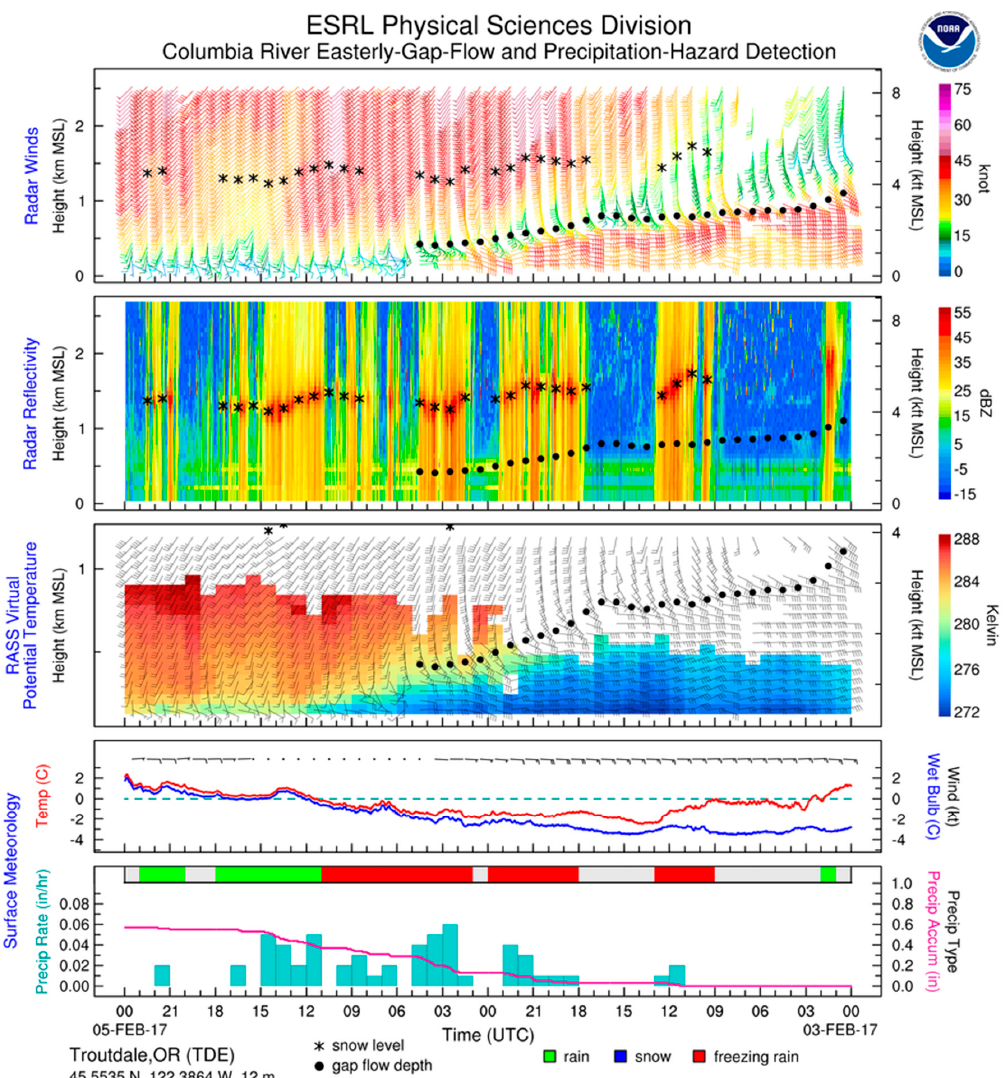
Figure 5. Gap flow events through the Columbia River Gorge, shown in the Winter Gap Flow tool. Top panel shows the time–height section of hourly radar wind profiles (flag: 50 kt, barb: 10 kt, half-barb: 5 kt) color coded by wind speed (kt). Hourly measurements of the snow level and the top of the gap flow are marked with stars and solid black dots, respectively. Second panel: time–height section of 3-min-resolution color-coded radar reflectivity (dBZ) from the vertical beam. The snow level and gap-flow top are marked as in the top panel. Third panel: time–height section of hourly radar wind profiles (flags and barbs are as in the top panel and hourly color-coded RASS virtual potential temperature (K)). The snow level and gap-flow top are marked as in the top panel. Bottom panel: The Surface Meteorology panel consists of two graphs. The temperature graph shows 2-min-resolution temperature (red; ◦ C) and wet-bulb temperature (blue; ◦ C). The horizontal dashed green line marks 0 ◦ C. In the same graph, surface time series of hourly wind velocities are shown, with flags and barbs as in the top panel; black dots portray observed wind speeds. The precipitation graph shows color-coded hourly precipitation type (across top of panel; color key at bottom), tipping-bucket hourly precipitation rate (in. hr − 1 ; blue bars), and 2-min-resolution precipitation accumulation (in.; pink line). Data and image provided by the NOAA / OAR / ESRL PSD, Boulder, Colorado, USA: http: // www.esrl.noaa.gov / psd / data / obs / datadisplay / . The real-time, web-based data product can be accessed on the WFVT webpage at by selecting a location from the station list, and then the “Precipitation Hazard Plot” link. As in the other graphics, English units are provided because of the preferences of the primary users of the